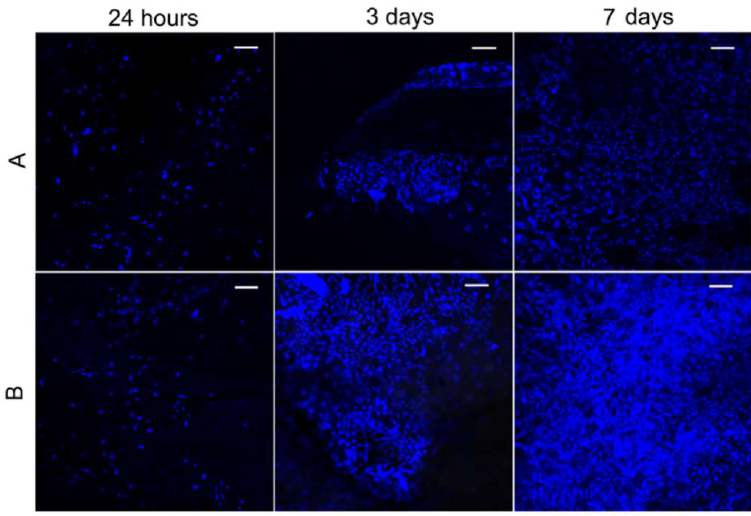
Figure 10. CLSM of chondrocytes proliferation on ( A ) non-porous PDLLA fibrous membrane; ( B ) PDLLA/nHA composite fibrous membrane. Scale bars represent 100 μm.